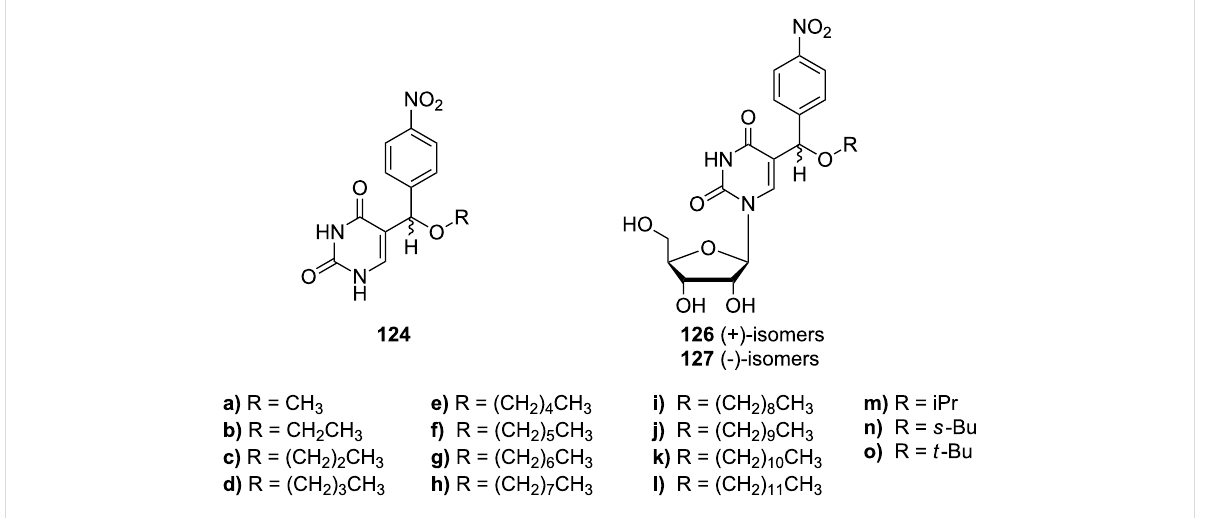
Figure 18: 5-[Alkoxy-(4-nitrophenyl)-methyl] uracil analogues 124 , 126 and 127 .